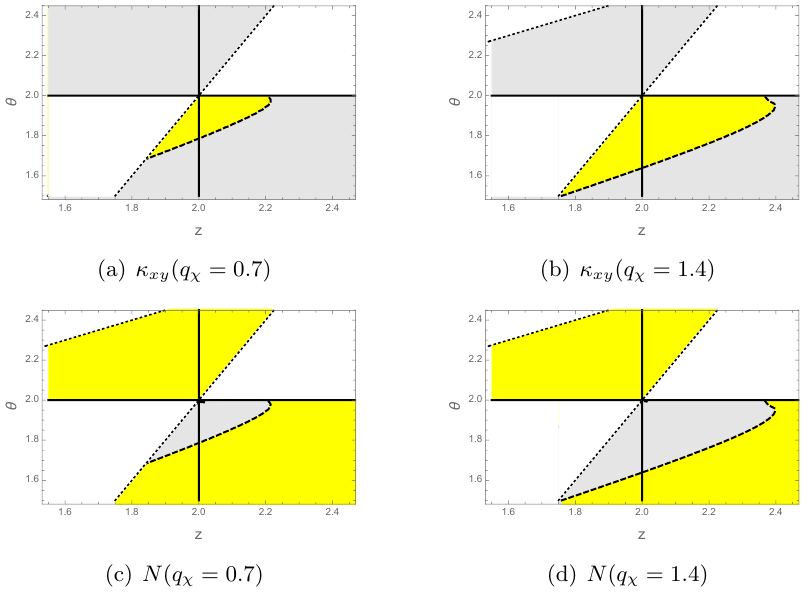
Figure 14 . (a,b) WL vs WAL in thermal conductivity. (c,d) WL vs WAL in Nernst signal. They are determined by sign of the coe(cid:14)cient of H 2 in case of (cid:20) xy or H in case of N. Yellow region denotes positive sign(WL) and gray region is for negative sign(WAL). Dotted line is for NEC. Here we use the same parameter of (cid:12)gures and T = 0 :